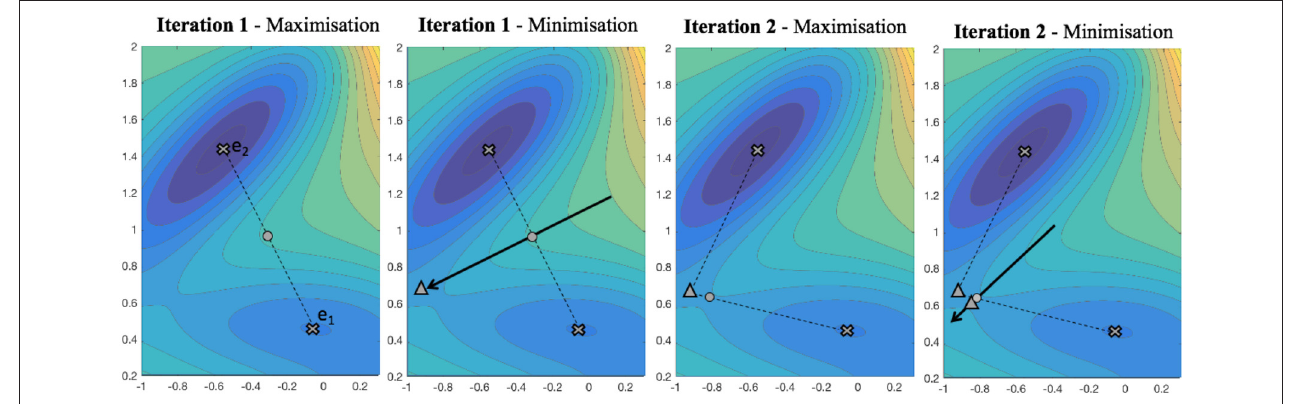
FIGURE 9 | Symbols denote: (